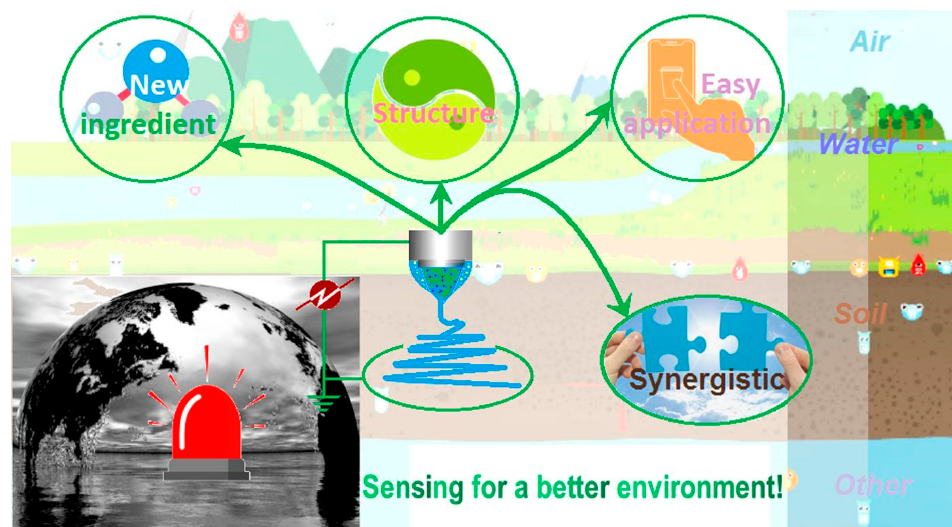
Figure 8. Application prospect of electrospinning technology in the improvement of detection of environmental chemosensors.